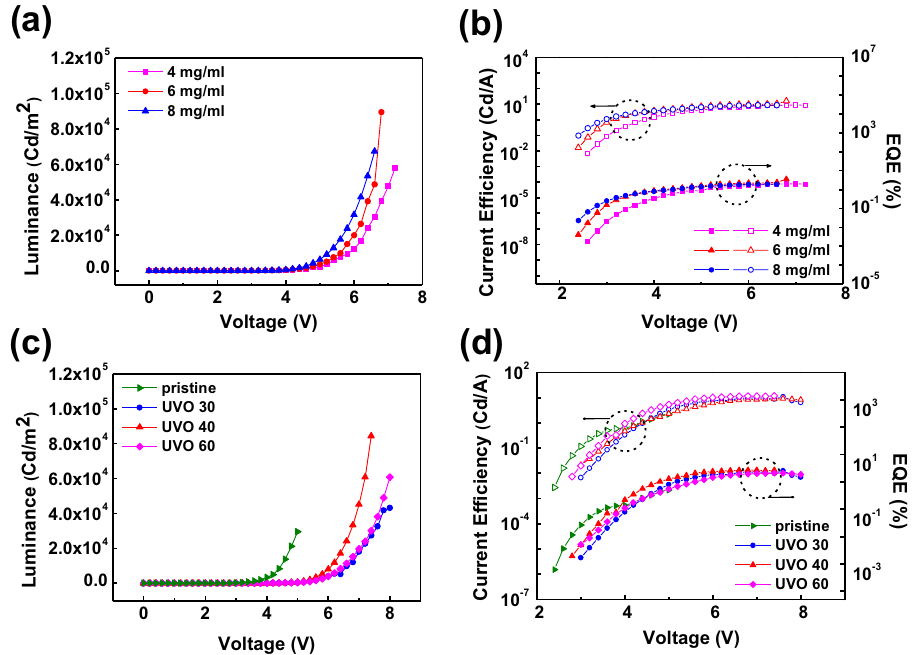
Figure 2. Performance of QLEDs with PTAA HTLs at various concentrations. ( a ) L-V and ( b ) CE-V-EQE curves. Performance of QLEDs with PTAA HTLs with various UVO times. ( c ) L-V and ( d ) CE-V-EQE curves. The QLEDs were fabricated on an ITO glass substrate.